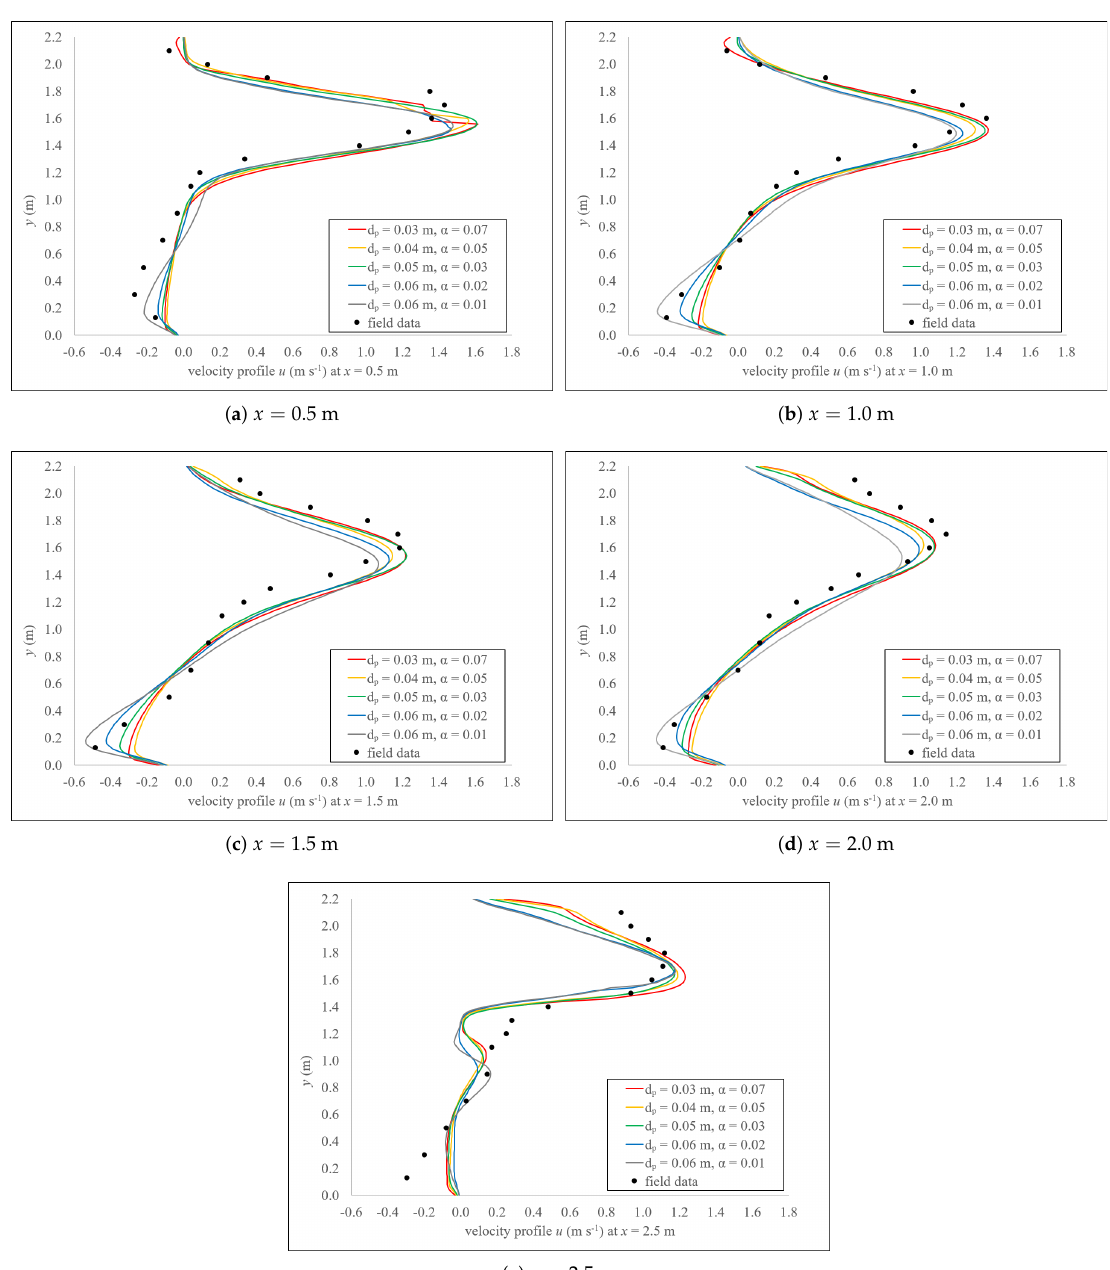
Figure 11. Average velocity profile of u at different x positions and for several different values of dp and α compared against field